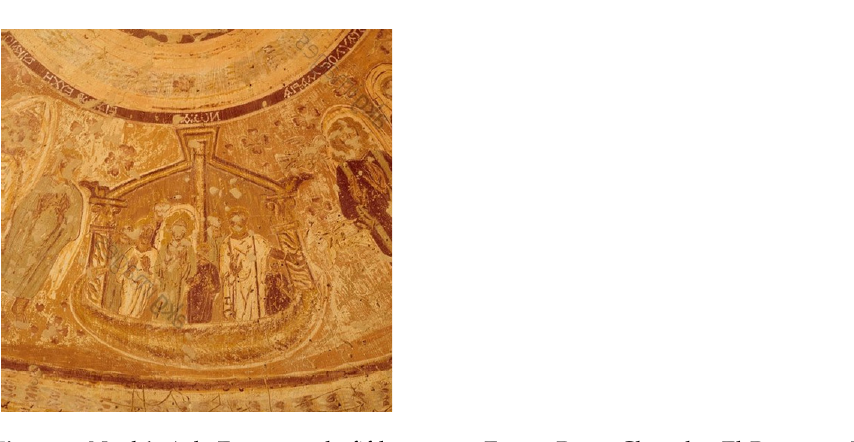
Figure 7. Noah’s Ark, Fresco, early fifth century, Egypt, Peace Chapel at El-Bagawat. Photograph: https://www.akg ‐ images.com/archive/ ‐ 2UMDHU2YKNXJ.html (accessed on 22 May 2020).